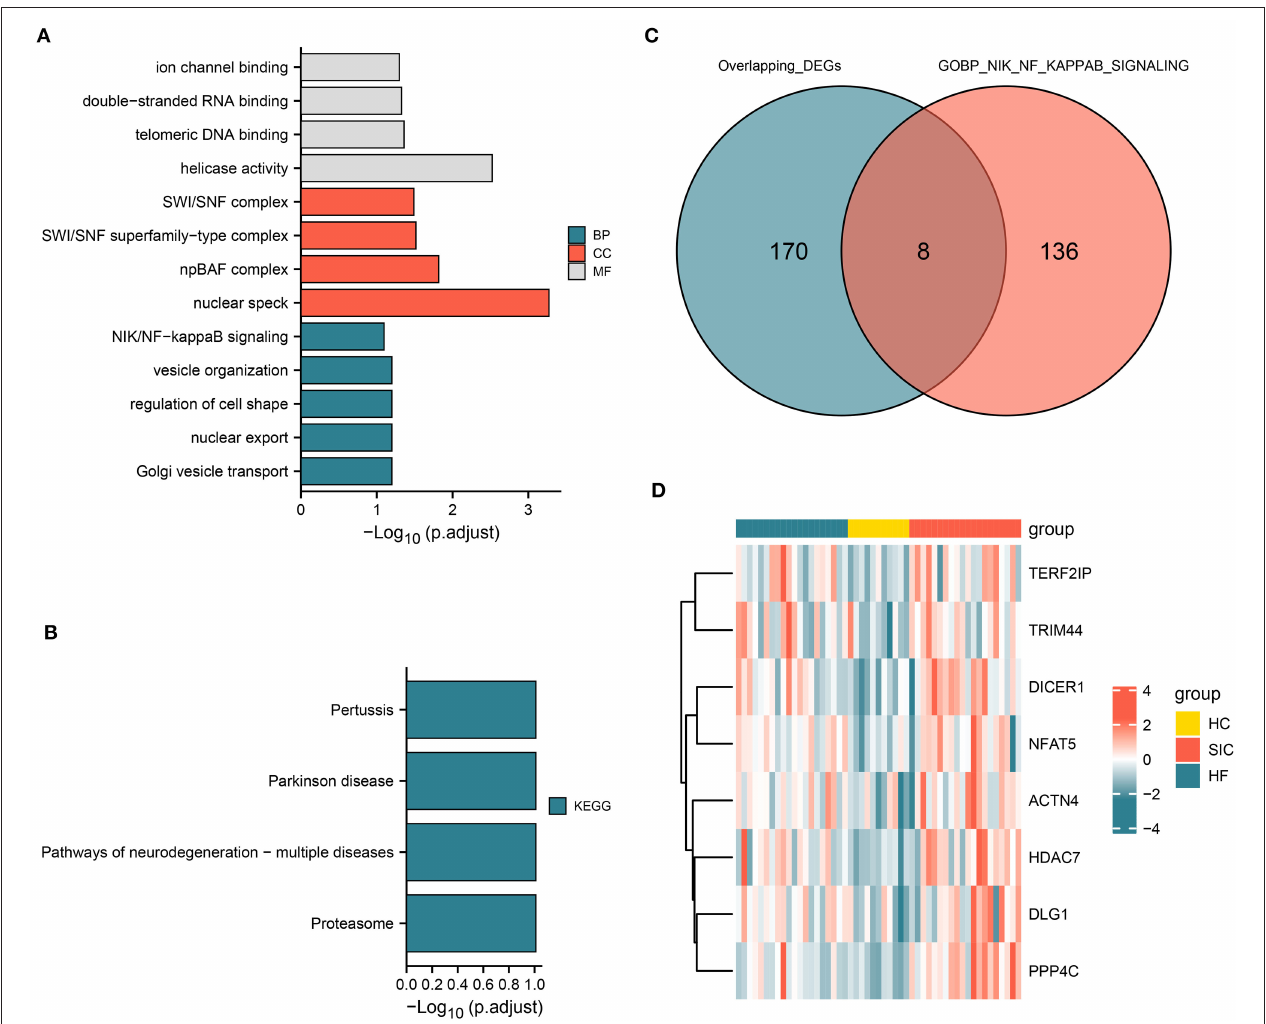
FIGURE 4 | Functional pathway analysis and genes associated with the NIK/NF-kappa B signaling pathway. (A) Pathways associated with upregulated genes; molecular function (MF), cellular component (CC), and biological process (BP). (B) Pathways related to upregulated and downregulated genes. (C) Intersection of the differentially expressed genes and genes involved in the NIK/NF-kappa B signaling pathway. (D) Heatmap showing the intersecting genes in each group.